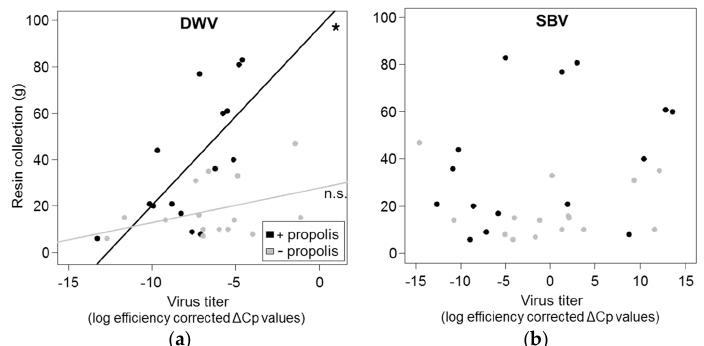
Figure 3. ( a , b ) Effect of viral infection with ( a ) deformed wing virus (DWV); and ( b ) sacbrood virus (SBV) on the amount of resin (g) collected by bees. Each dot represents data from one colony for one month. Lines represent linear regression between resin collection and virus titers (log efficiency corrected fold-change relative to housekeeping gene) for each treatment group (black = ”high propolis treatment”, gray = “low propolis treatment”) with * indicating a significant correlation with p < 0.05 and n.s. a non-significant correlation. Table 3. Results of mixed-effects models testing for effects of V. destructor infestation (“Varroa”), DWV infection (DWV) and treatment (“Treatment”) as well as their interactions (indicated with x) on the quantity of resin collected by each colony over three months (number of samples N = 30, three repeats per colony). In all models, colony and month were included as random factors to take into account colony-specific differences and repeatedly measuring the same colony. Table shows p -values ( p ) and R 2 -values (i.e., percentage explained variance) for comparing all models presented against the null model (i.e., a model including only colony and sampling date as random factors), marginal R squared values (R 2 m: representing the explanatory power of the fixed effects only) and conditional R squared values (R 2 c: representing the explanatory power of the whole model, including the random effects). Significant p -value is marked in bold.